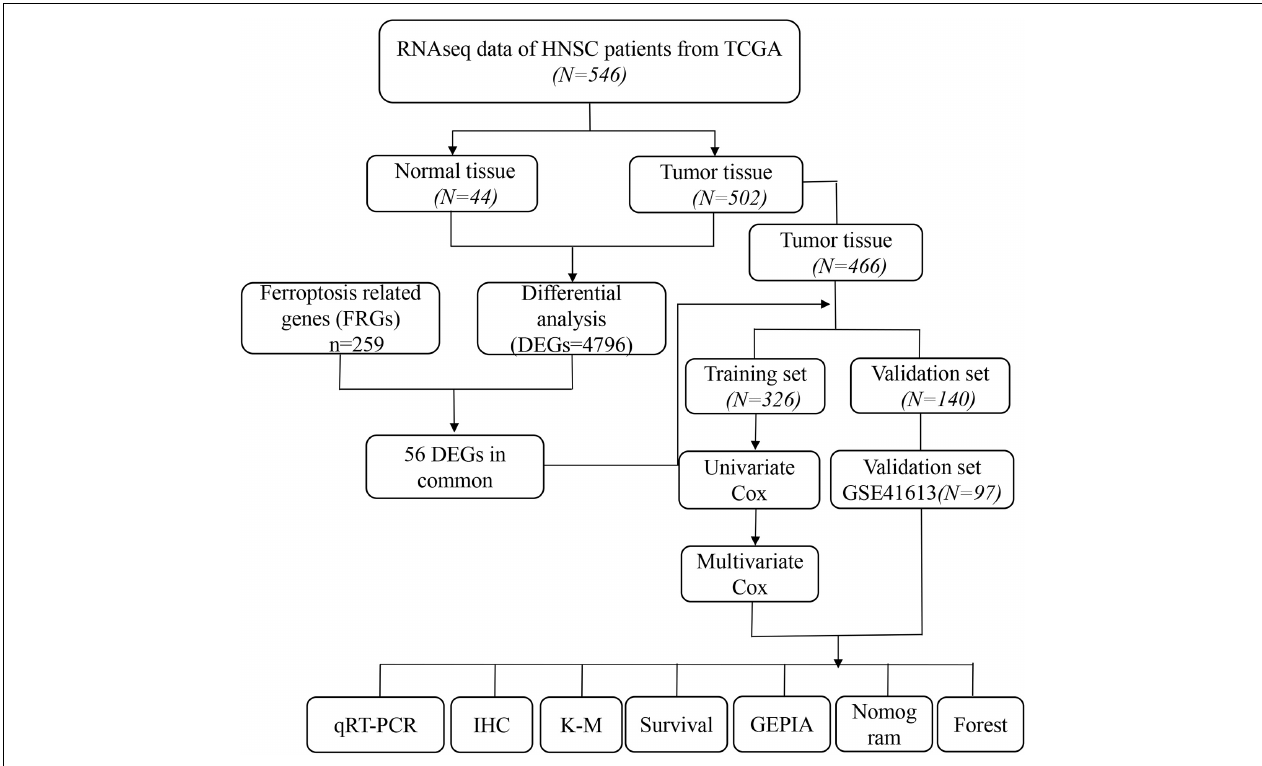
FIGURE 1 | Flow chart of overall study design and